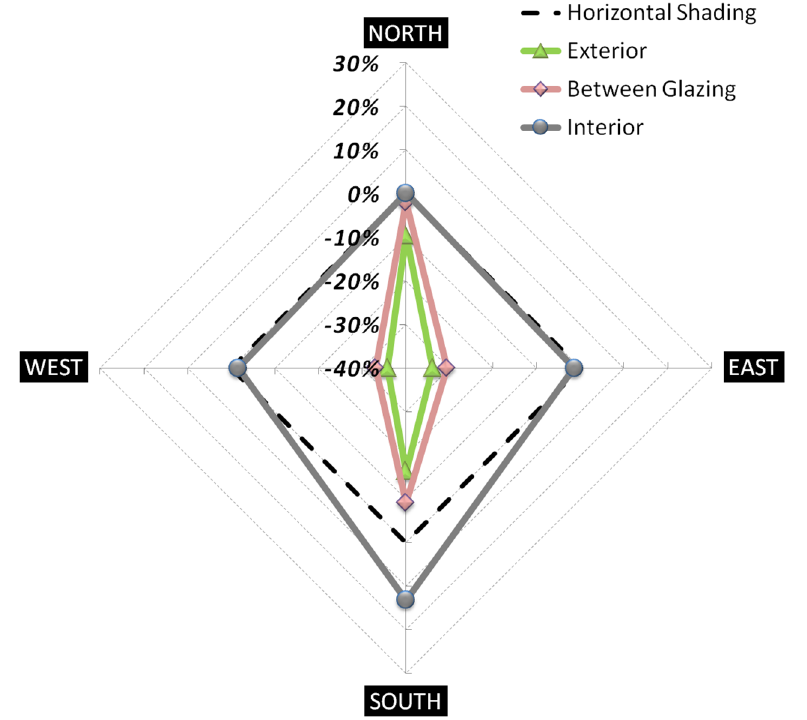
Figure 13. Saving ratio of the heating and cooling load according to the type of shading (WWR 80%, U-value: 2.1, SHGC: